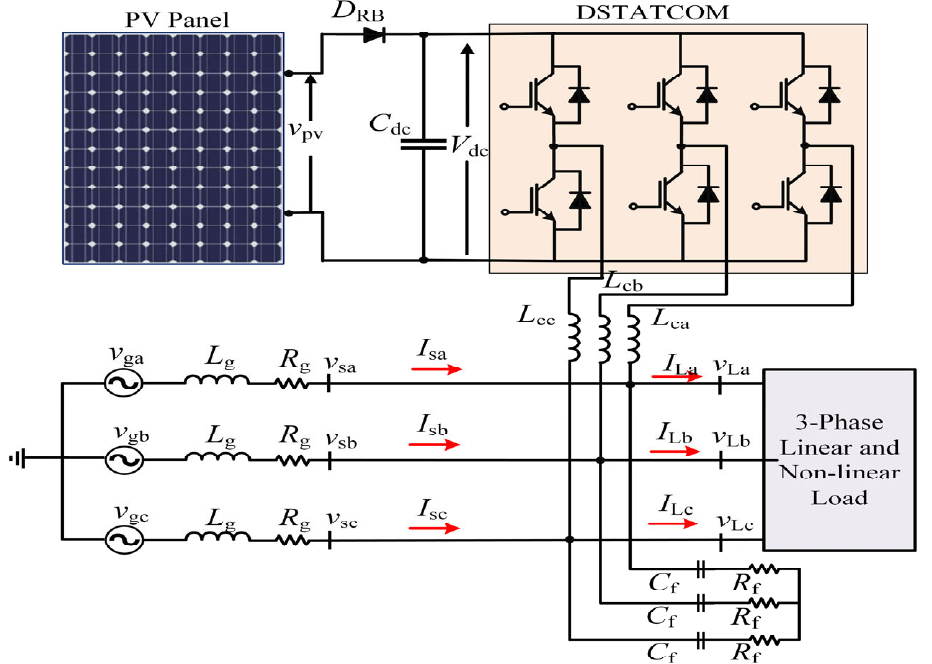
Figure 1. System configuration.